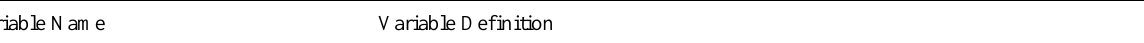
Table 1. Definition of explanatory